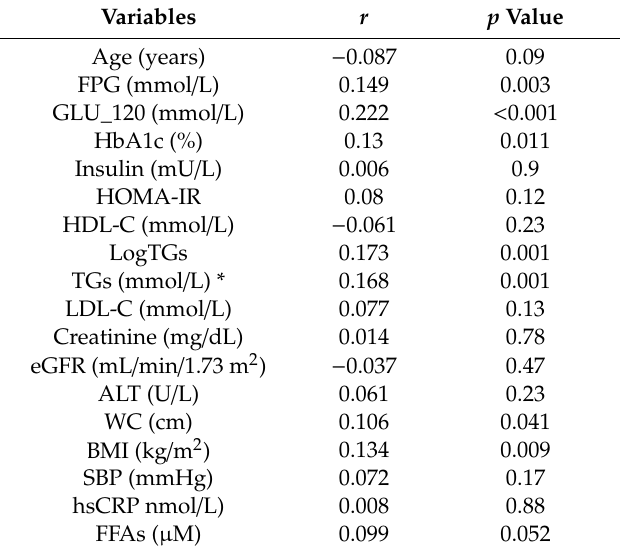
Table 2. Correlations of serum secretogranin III (SCG3) levels and clinical parameters in all subjects.